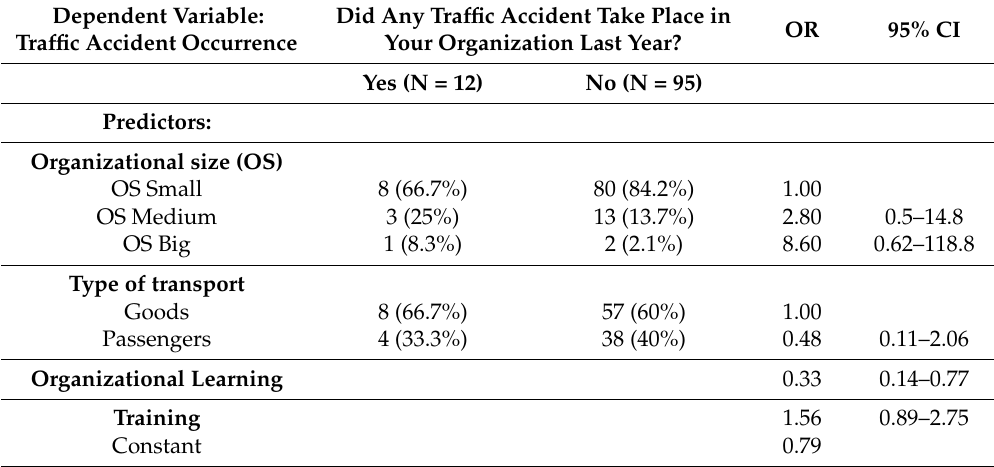
Table 3. Organizational factors and traffic accident occurrence. Results of the binary logistic regression